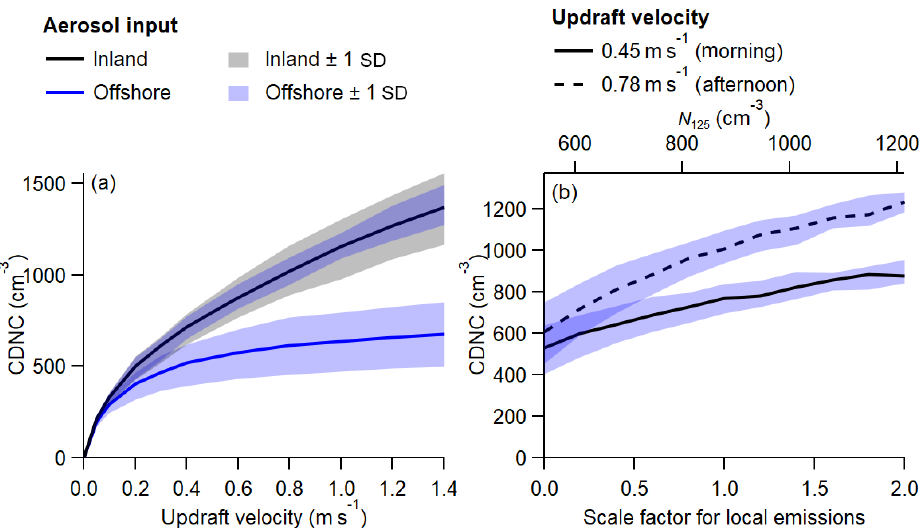
Figure 9. CDNC calculated during ACPIM parcel model runs initialised using measured aerosol size distributions and compositions shown in Fig. 8 and Table 2. The shaded regions show the expected day-to-day variability in CDNC as a result of variation in the aerosol concentrations, based on the standard deviation of measurements shown in Fig. 6a. Panel (a) shows the sensitivity of CDNC to updraft velocities and panel (b) the sensitivity to different scale factors for local emissions in the aerosol input. The smaller and larger updraft velocities in panel (b) are representative of morning and